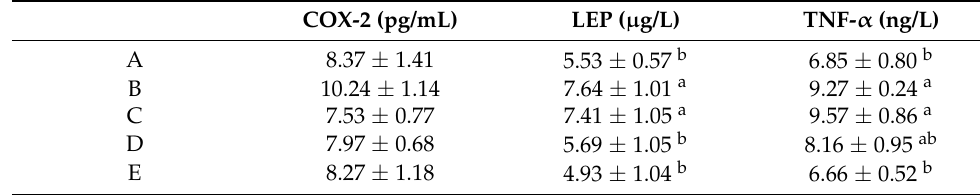
Table 4. Effects of different GSP groups on COX-2, LEP, TNF- α mRNA expression in adipose tissue of